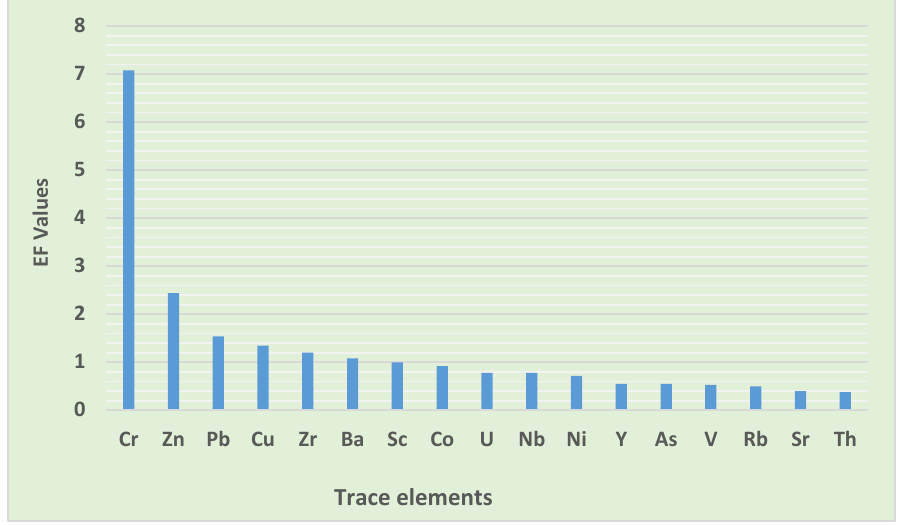
Figure 5. Enrichment factor values of trace elements in road dust. Table 9. Correlation matrix of trace elements in road